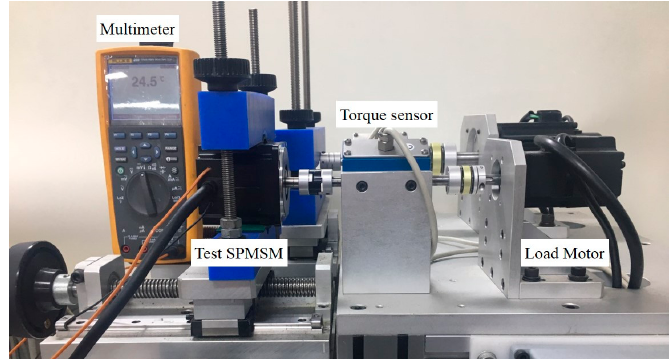
Figure 10. Experimental test set up